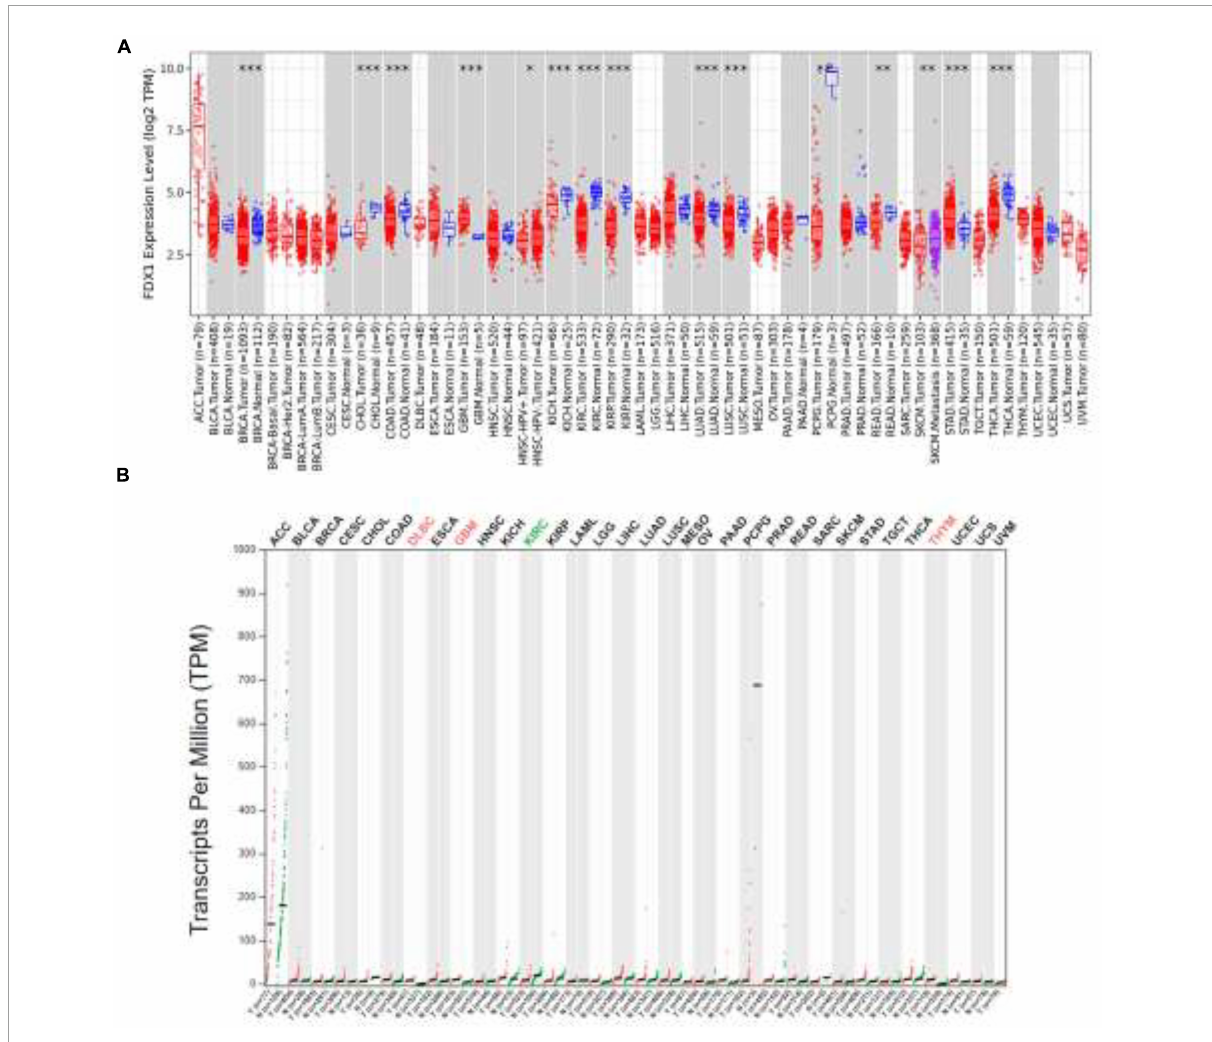
FIGURE1 Expression of FDX1 gene in different cancers. (A) Expression of FDX1 gene in different cancer and normal tissues of TIMER2.0 database (* P ≤ 0.05, ** P ≤ 0.01, *** P ≤ 0.001). (B) Expression of FDX1 Transcripts in different cancer and normal tissues in GEPIA database (* P ≤ 0.05, ** P ≤ 0.01, *** P ≤